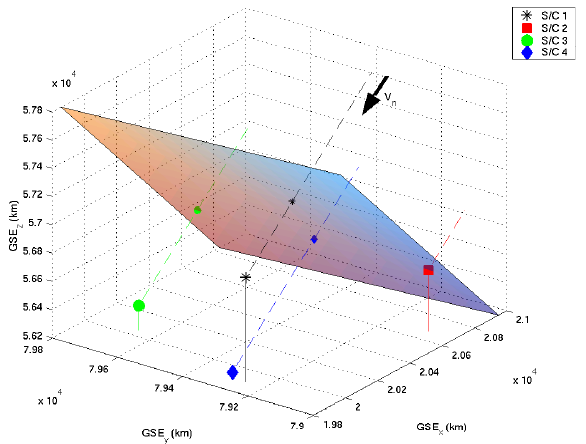
Fig. 5. A sketch of the location of the Cluster satellites and the orientation of the magnetopause during the magnetopause crossing on 31 December 2000, near 10:17 UT. Satellites 1 to 4 are indicated by black, red green and blue, respectively.